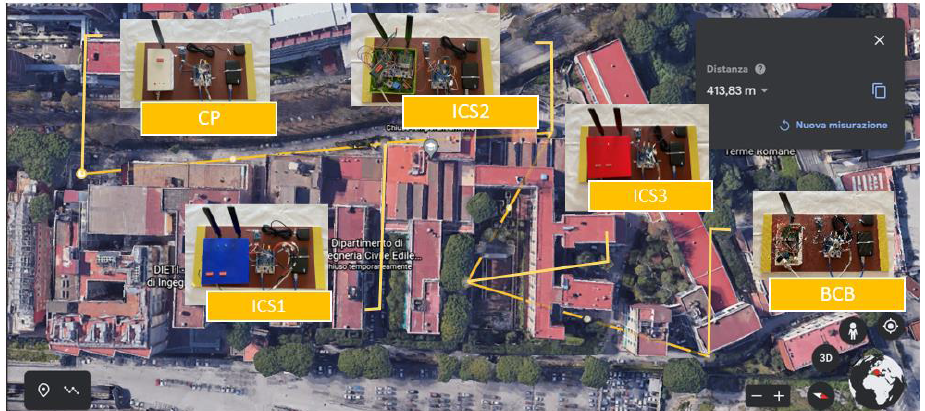
Figure 9. Position of devices for tests in urban environment.